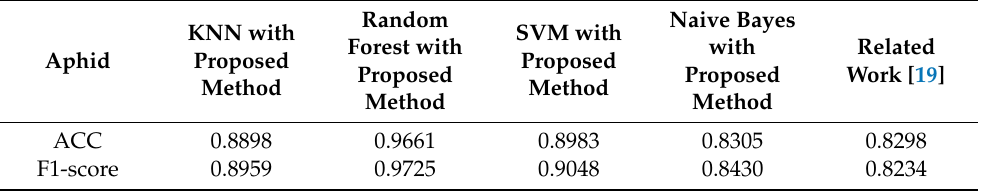
Table 10. Results for prediction of the number of aphid pests.